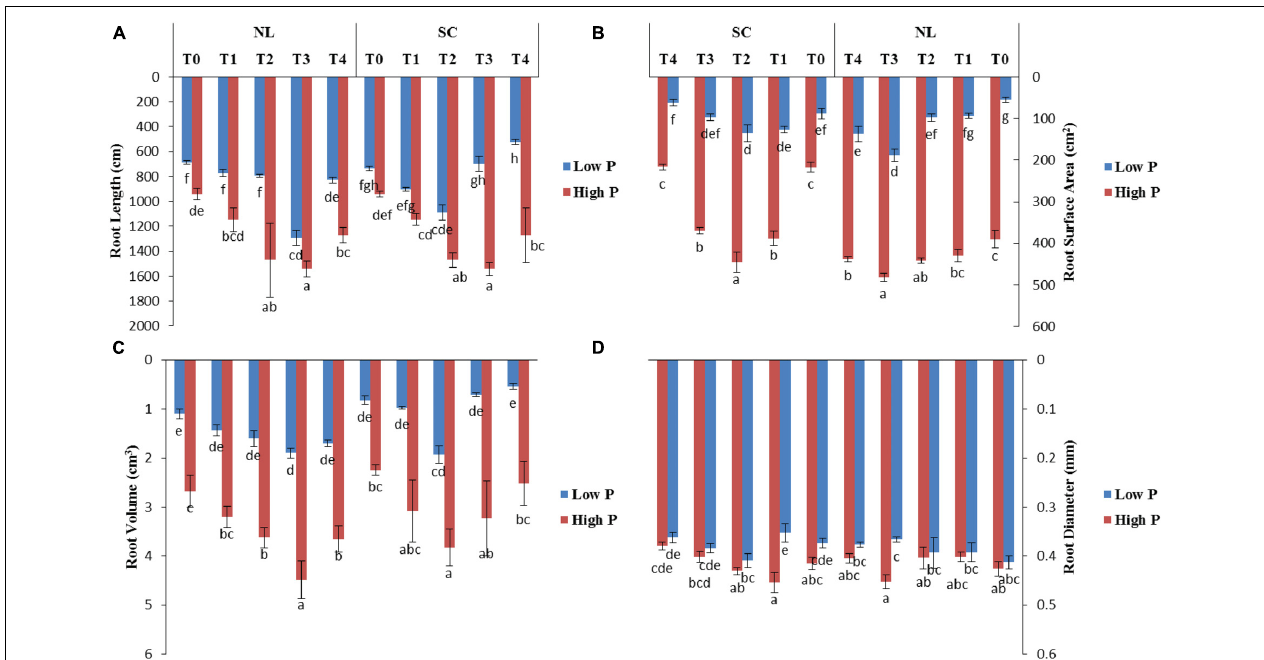
FIGURE 8 | Effect of Ti application on (A) root length, (B) root surface area, (C) root volume, and (D) root diameter of soybean under NL and SC combined with LP and HP conditions. The bar plots with different lettering show the significant difference among cultivars at probability < 0.05. The error bars are the ± SD values with n = 3.